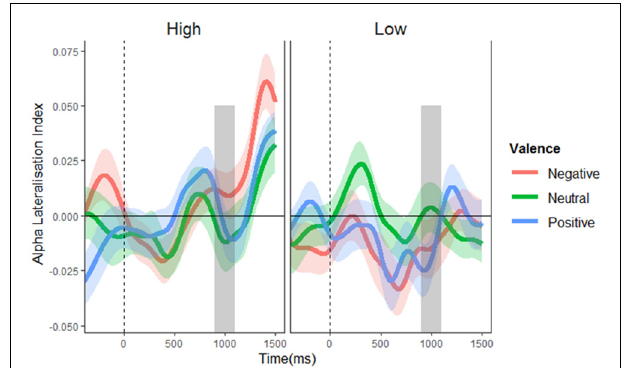
FIGURE 4 | Alpha lateralization indices. Alpha lateralization indices for the low and high distractor frequency conditions, as a function of valence block. A negative value indicates greater alpha power over the side contralateral to the potential distractor location (indicating suppression at potential distraction locations), with a value of zero signifying the absence of lateralized differences. The gray box indicates the time window of possible stimulus onset. No significant alpha lateralization was